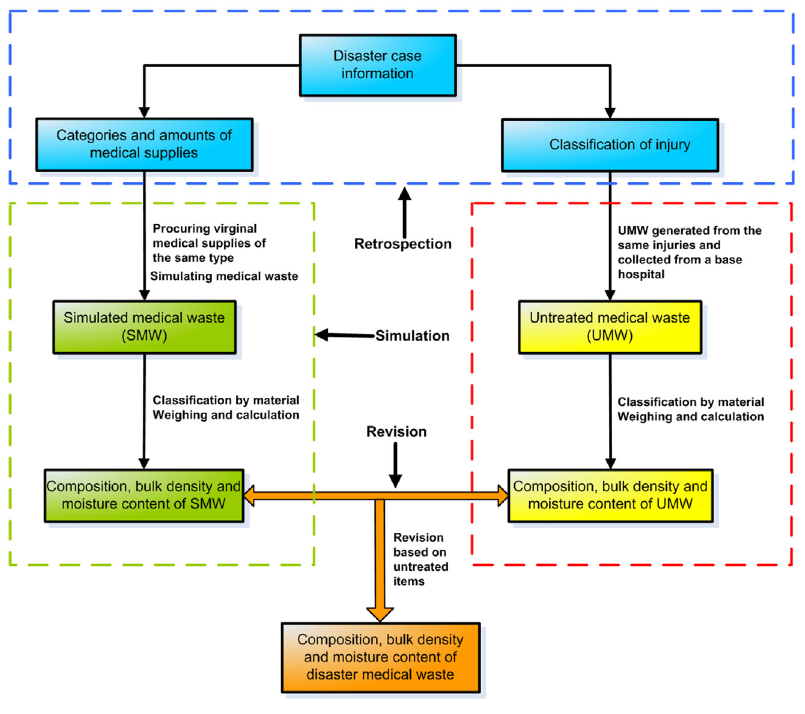
Fig 1. Schema of